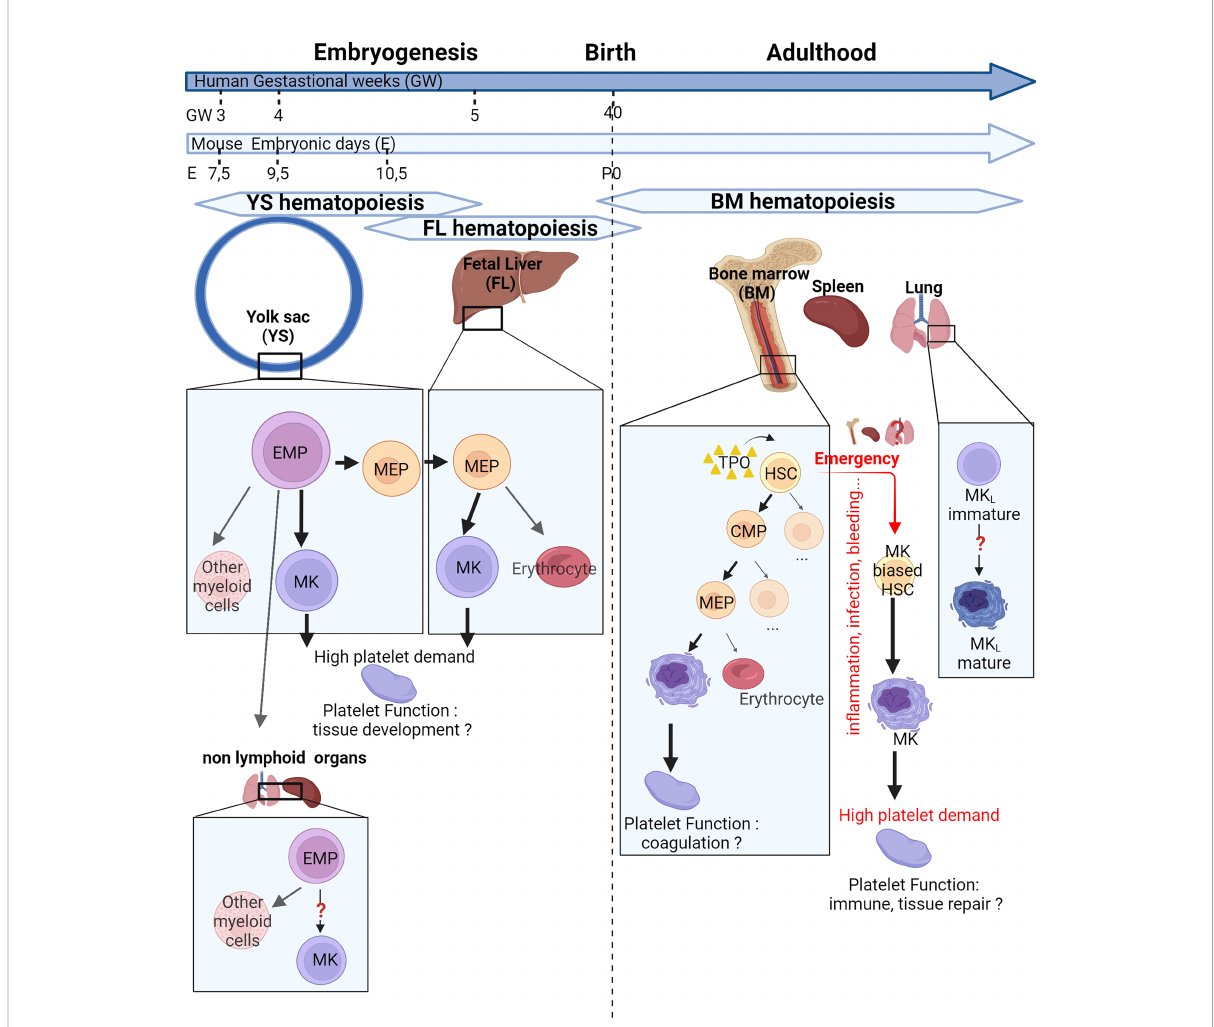
FIGURE 1 Place and mechanisms of megakaryocyte differentiation over time. The hematopoiesis begins in the yolk sac at 7.5 days post-conception (E7.5) in mice or 3 gestational weeks (GW) in human. At E9.5 or at GW4, the fi rst megakaryocytes (MKs) originate from yolk sac-derived erythroid – myeloid progenitors (EMPs) bypassing the bipotential MK – erythrocyte progenitors (MEPs). Later, a new wave of MKs originate from bipotential MEPs in the fetal liver. EMPs can colonize nonlymphoid organs and are capable of differentiation in myeloid cells. After birth, the bone marrow gradually takes over from the liver. MKs can differentiate from multipotent progenitors (MPPs) or, in case of high platelet need, directly from MK-biased hematopoietic stem cells (HSCs). Extramedullary megakaryopoiesis also occurs in the spleen in case of sepsis. Finally, the lung presents MK progenitors and resident MKs presenting an immune phenotype. These different MK subsets could produce specialized platelet populations capable of immune functions and tissue development. CMP, common myeloid progenitor; MKL, Lung resident Megakaryocytes; TPO,